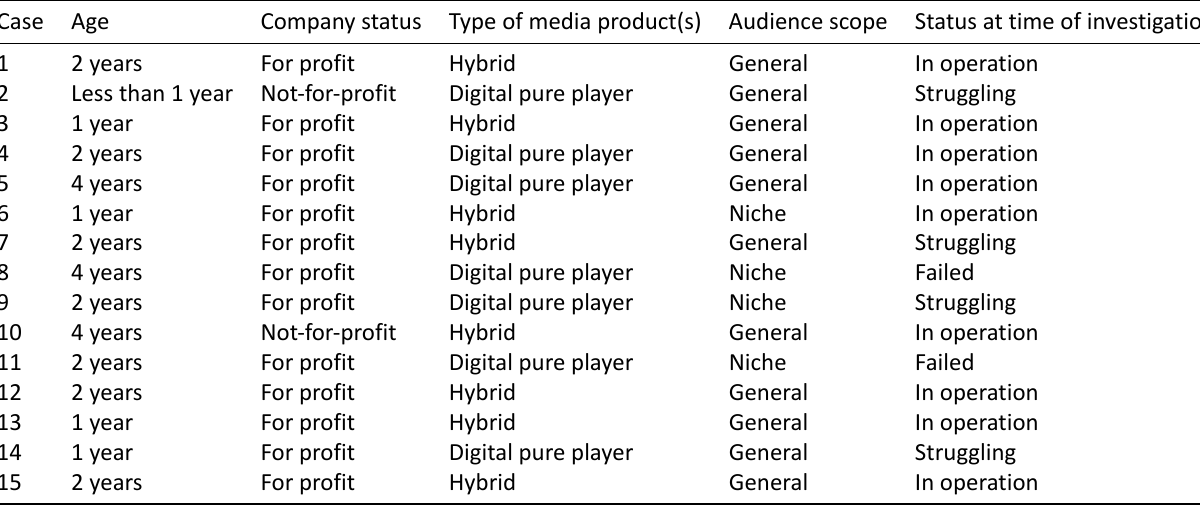
Table 1. Cases investigated in empirical